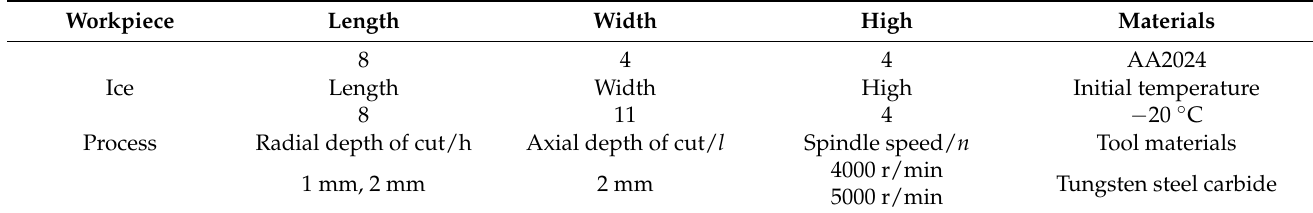
Figure 3. Milling simulation of workpiece under IBC. Table 6. Boundary conditions.